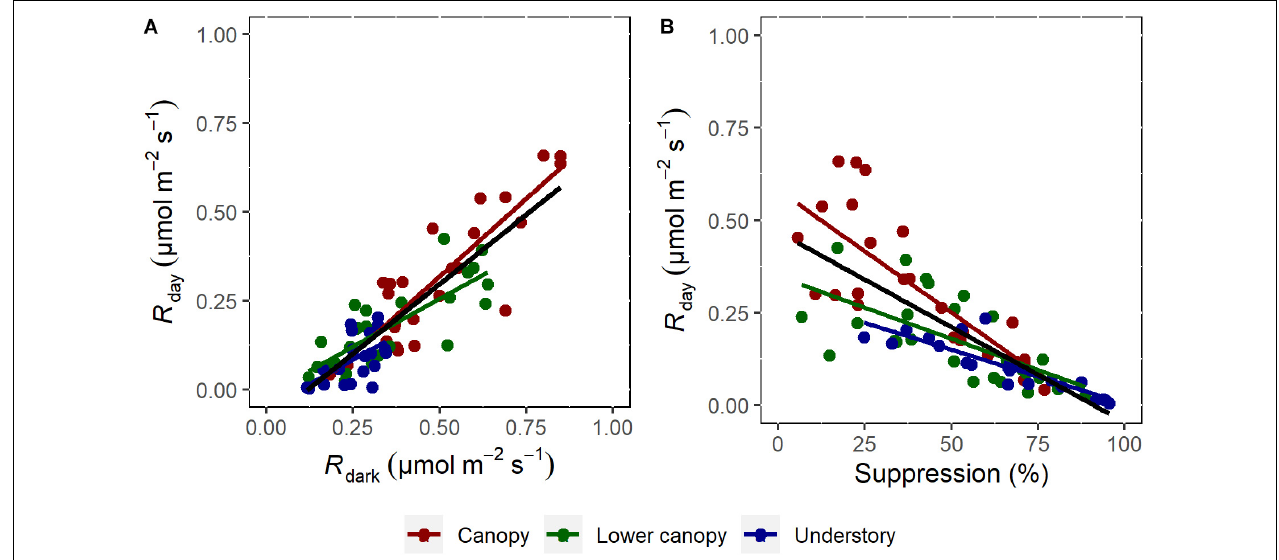
FIGURE 4 | Respiration rates in the light as a function of respiration in the dark (A) , and respiration in the light as a function of light suppression (B) . The data were obtained from the measurements collected in the understory (blue), lower canopy (green), and canopy trees (red), n = 74–76. Results from the standardized major axis (SMA) regression are presented in Supplementary Table 1 . Note that when no significant relationship between the variables was found, the regression line was